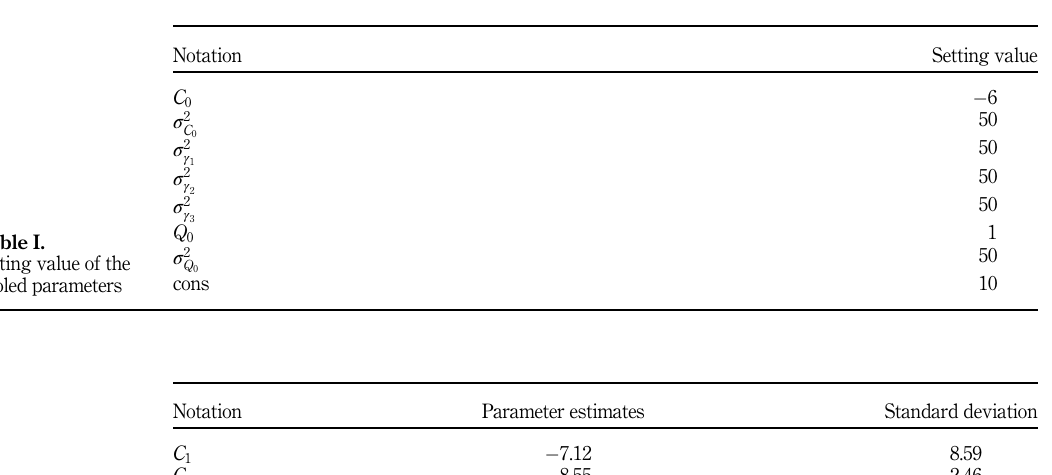
Table II. Estimates of the pooled